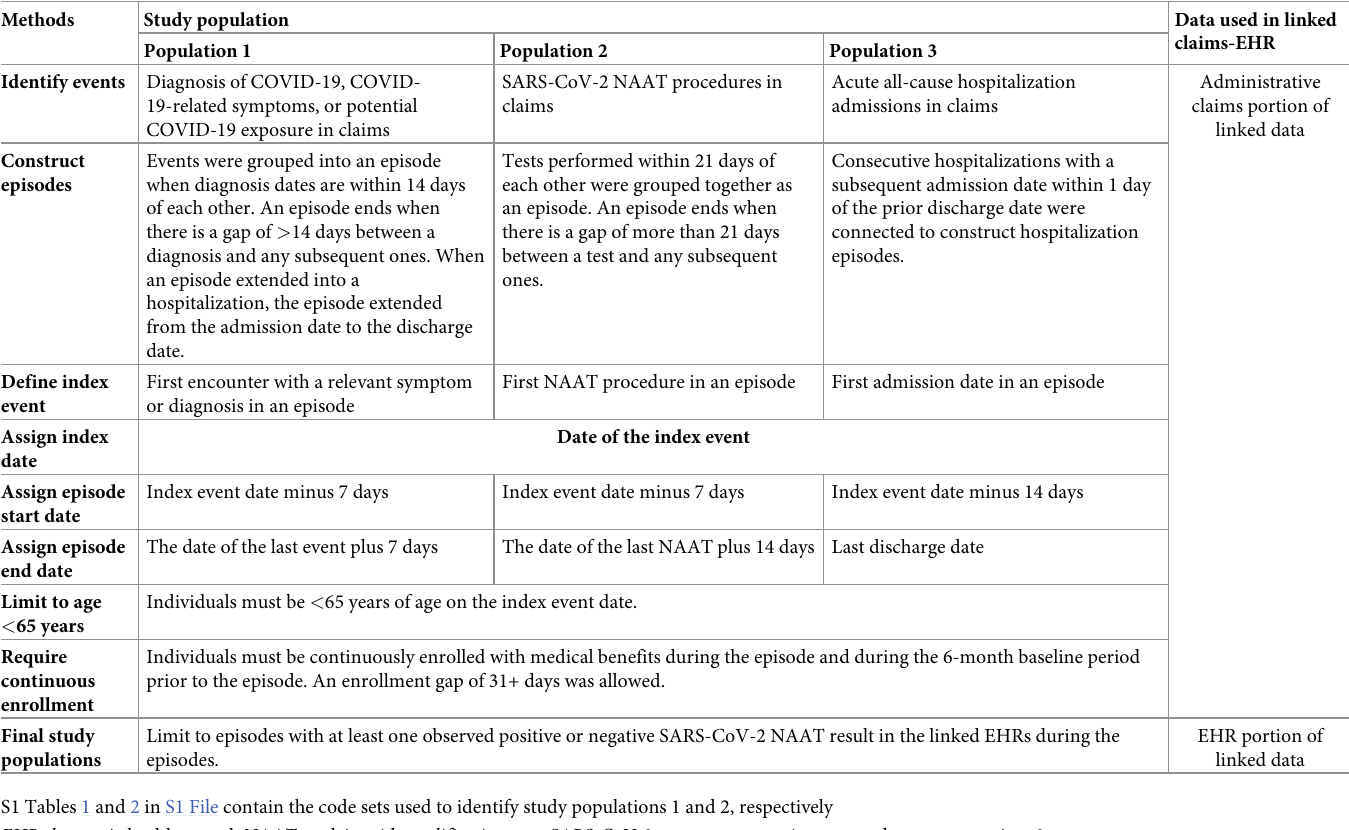
Table 1. Steps to identify care episodes for three study populations from the linked claims-EHR